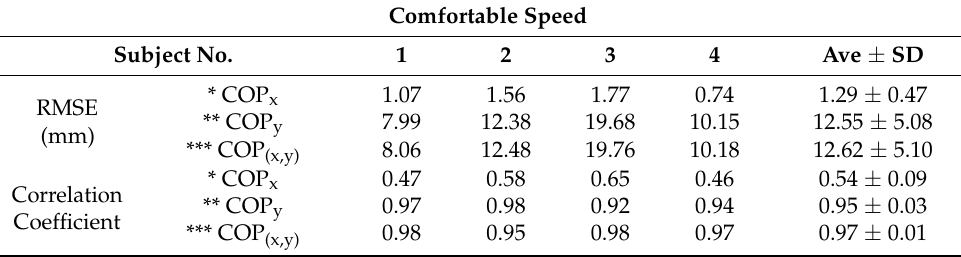
Table 4. Results of RMSE and correlation between I-TCPs and F-scan at comfortable gait speeds. Comfortable Speed